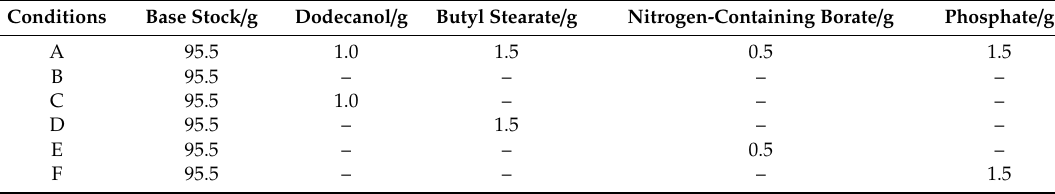
Table 1. Compositions of di ff erent testing conditions, the fully formulated rolling oil (A), the base stock (B), and the base stock containing only dodecanol (C), butyl stearate (D), Nitrogen-containing borate (E) or phosphate